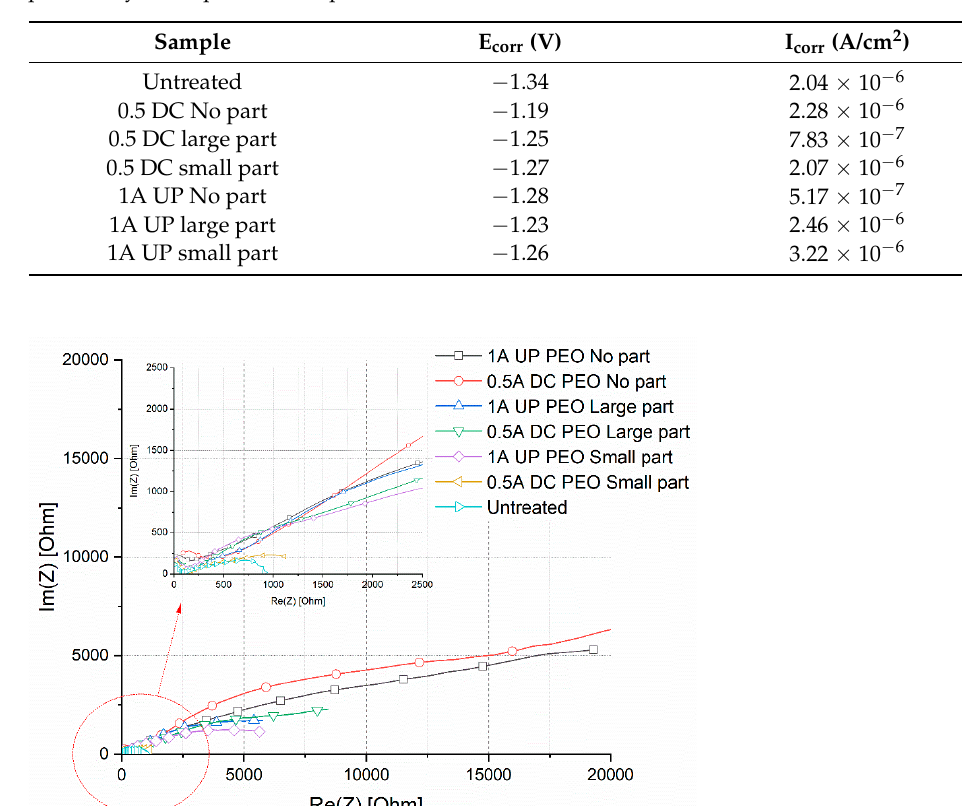
Figure 9. Results of the EIS tests in term of Nyquist plot. In the high left, the zone at the high fre- quencies can be observed in more detail. Test electrolyte: 0.1 M Na 2 SO 4 and 0.05 M NaCl.